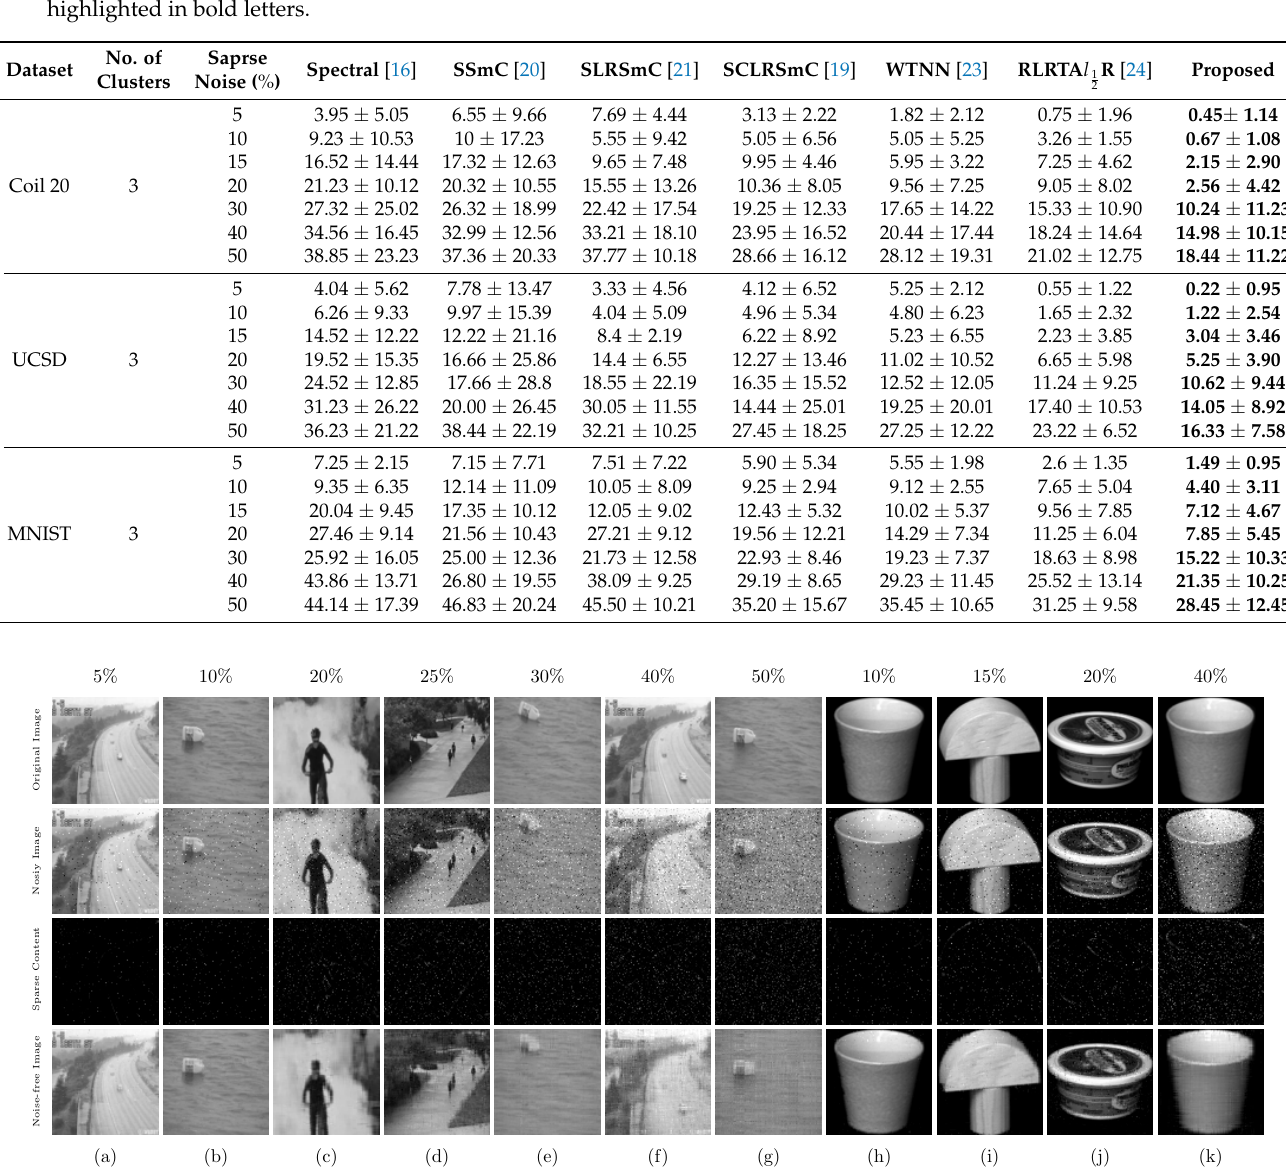
Figure 4. Illustrated noise-removed images achieved using proposed method from UCSD dataset ( a – g ) and Coil20 dataset ( h – k ) for various levels of sparse noise. The sparse noise levels are indicated on the top of each input image. First row: original input image, second row: images that have been corrupted by various levels of sparse noise, third row: eliminated sparse noise content from each image, fourth row: noise-removed